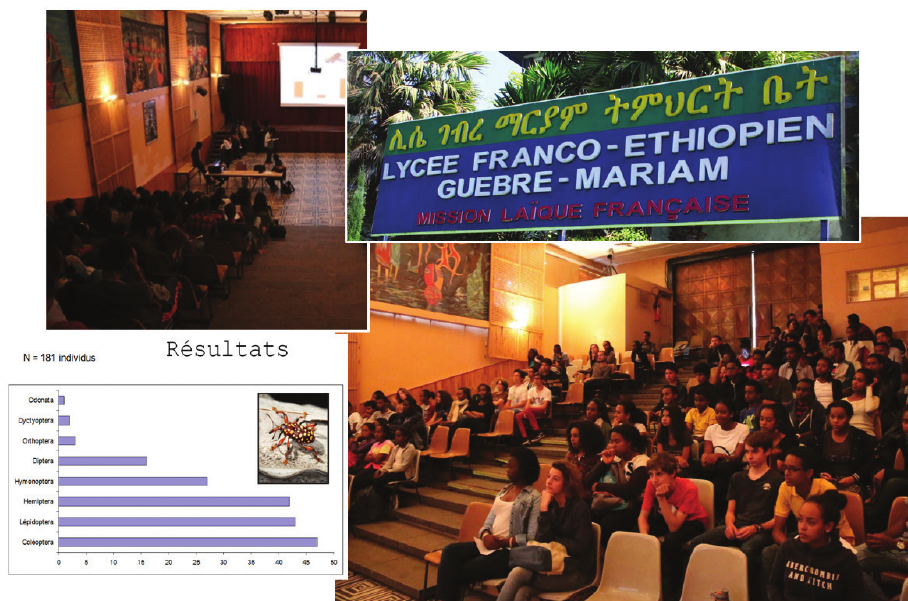
Figure 5. The French High School Guebre-Mariam, managed by the Mission laïque française and gov- ernment-regulated with the AEFE (Agency for French education abroad). An example of results produced during the programme and, inside the high school, the amphitheatre that offers the opportunity for stu- dents to organise and follow their own symposium, a chance to develop maturity, motivation, leadership and self-confidence